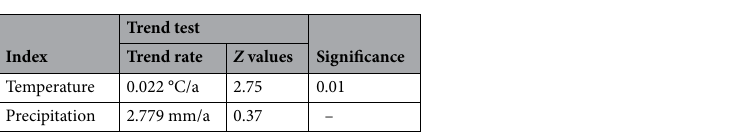
Figure 2. The trend analyses of temperature and precipitation in SRW for 1980–2010.